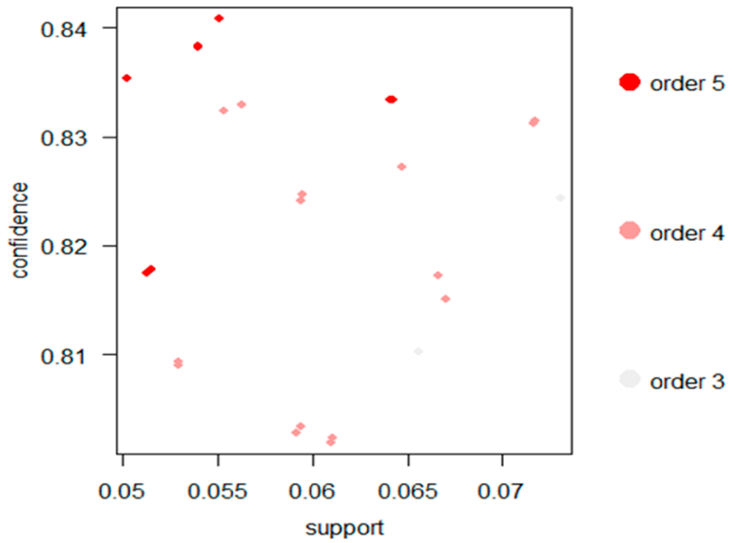
Figure 2. Two-key plot for the 26 rules.